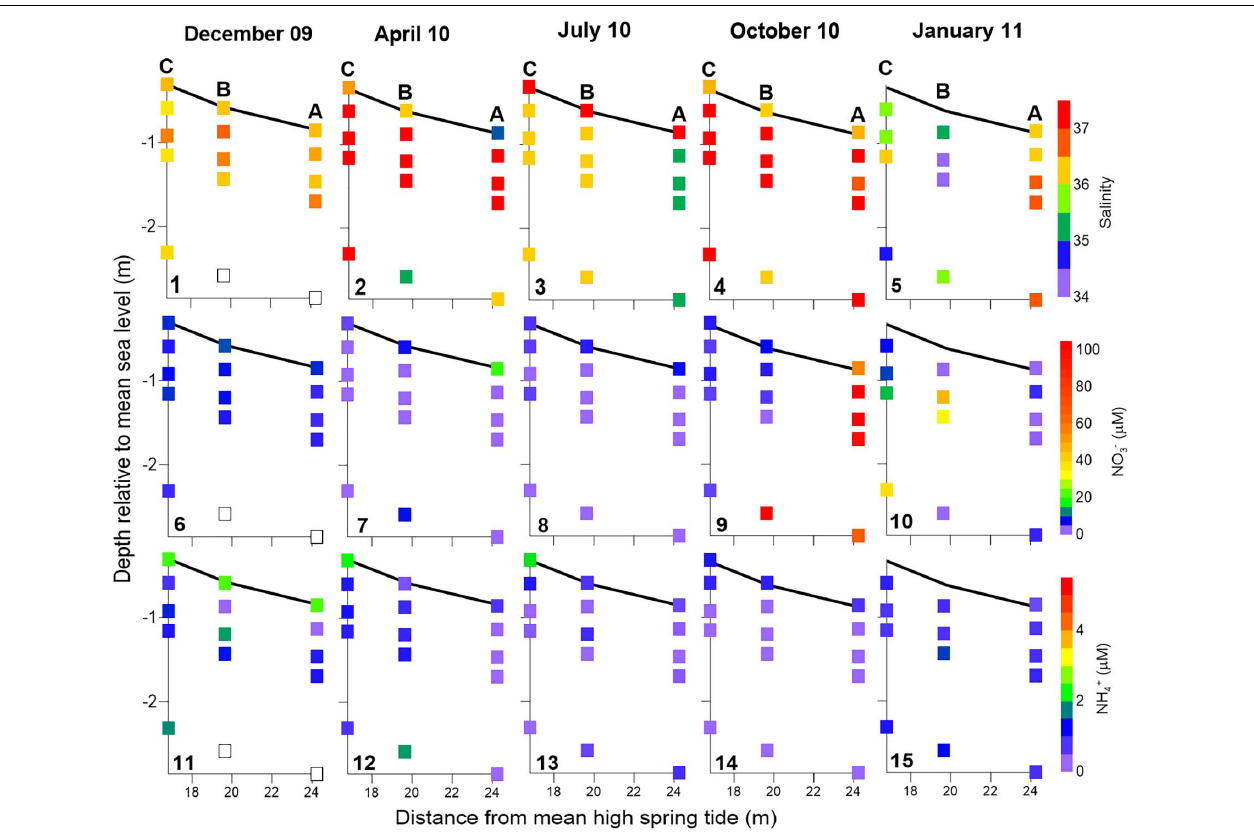
FIGURE 5 | Solute distribution within the seepage face at the beginning of sediment exposure during low tide. Salinity (panels 1–5), NO 3 − (panels 6–10), and NH 4 + (panels 11–15) are shown for the five surveys presented here. Data are represented on the beach profile, where the dark line represents sediment surface. Samples were collected with piezometers buried at different depths and seepage meters. Seepage meter data corresponding to half an hour around the time of piezometer sampling were integrated at each sampling station and presented at the sediment surface. Sampling stations are labeled in the top panels. White squares mean lack of